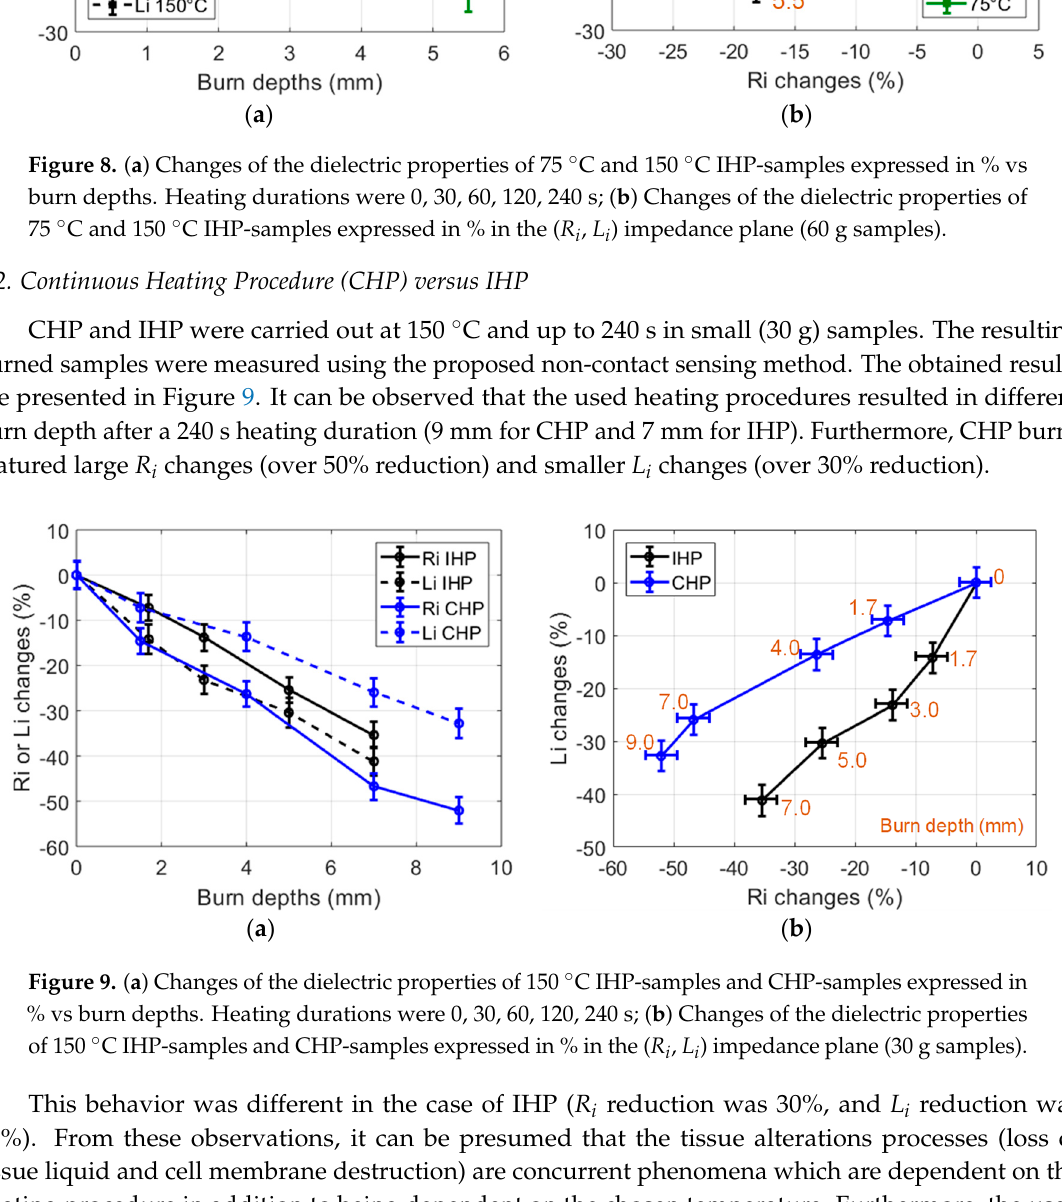
75 °C and 150 °C IHP-samples expressed in % in the ( R i , L i ) impedance plane (60 g samples).